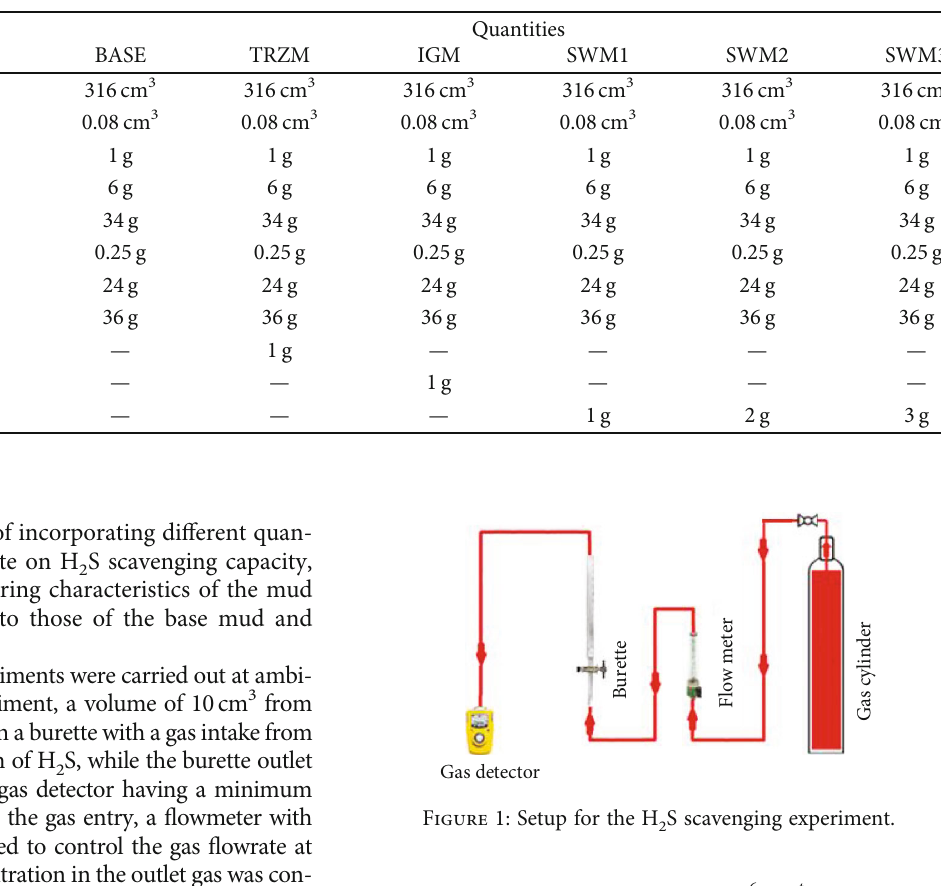
Table 2: The prepared drilling fl uid formulation.